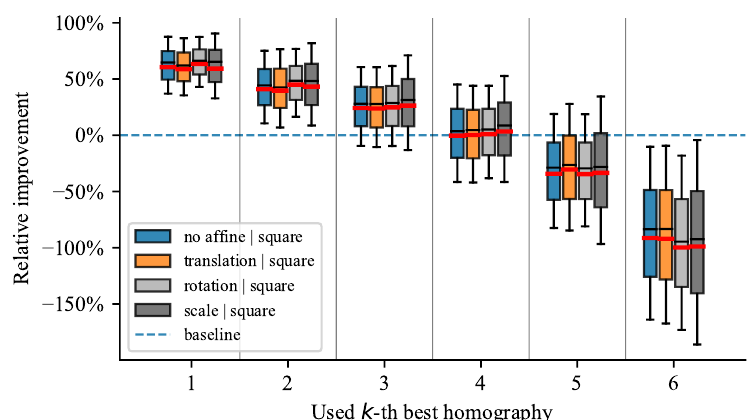
Figure 6. Influence of similarity transformation on the reprojection error.